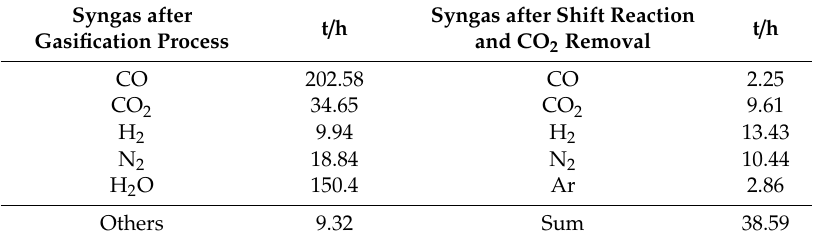
Table 3. Syngas composition after gasification and carbon dioxide